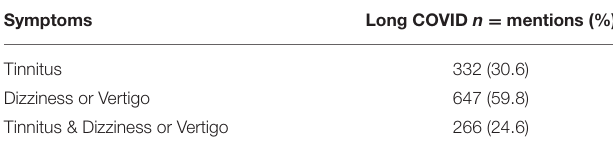
TABLE 1 | Demographics of survey respondents with Long COVID. TABLE 2 | Self-reported symptoms of survey respondents with Long